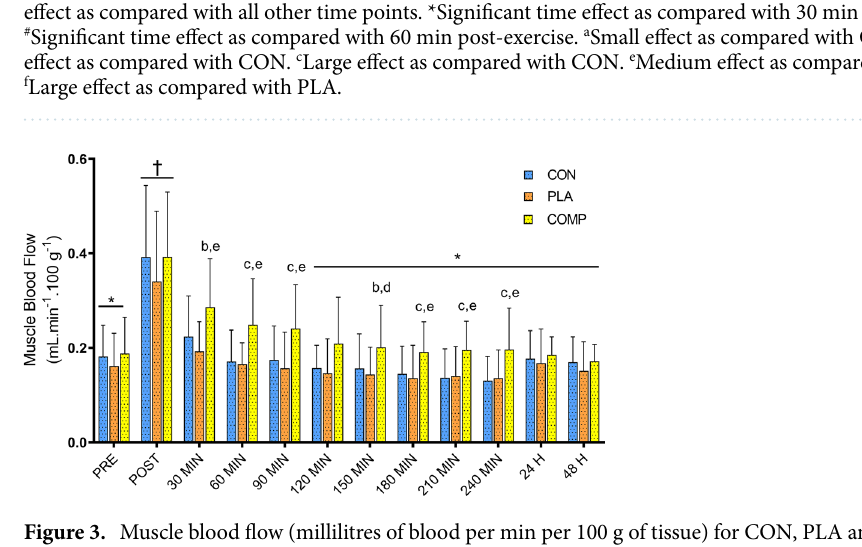
Figure 3. Muscle blood flow (millilitres of blood per min per 100 g of tissue) for CON, PLA and COMP conditions. Time points are before exercise (PRE), immediately post-exercise (POST), 4 h recovery (30– 240 min), and 24 and 48 h post-exercise. All data presented as mean ± SD. † Significant time effect as compared with all other time points. *Significant time effect as compared with 30 min post-exercise. b Medium effect as compared with CON. c Large effect as compared with CON. d Small effect as compared with PLA. e Medium effect as compared with